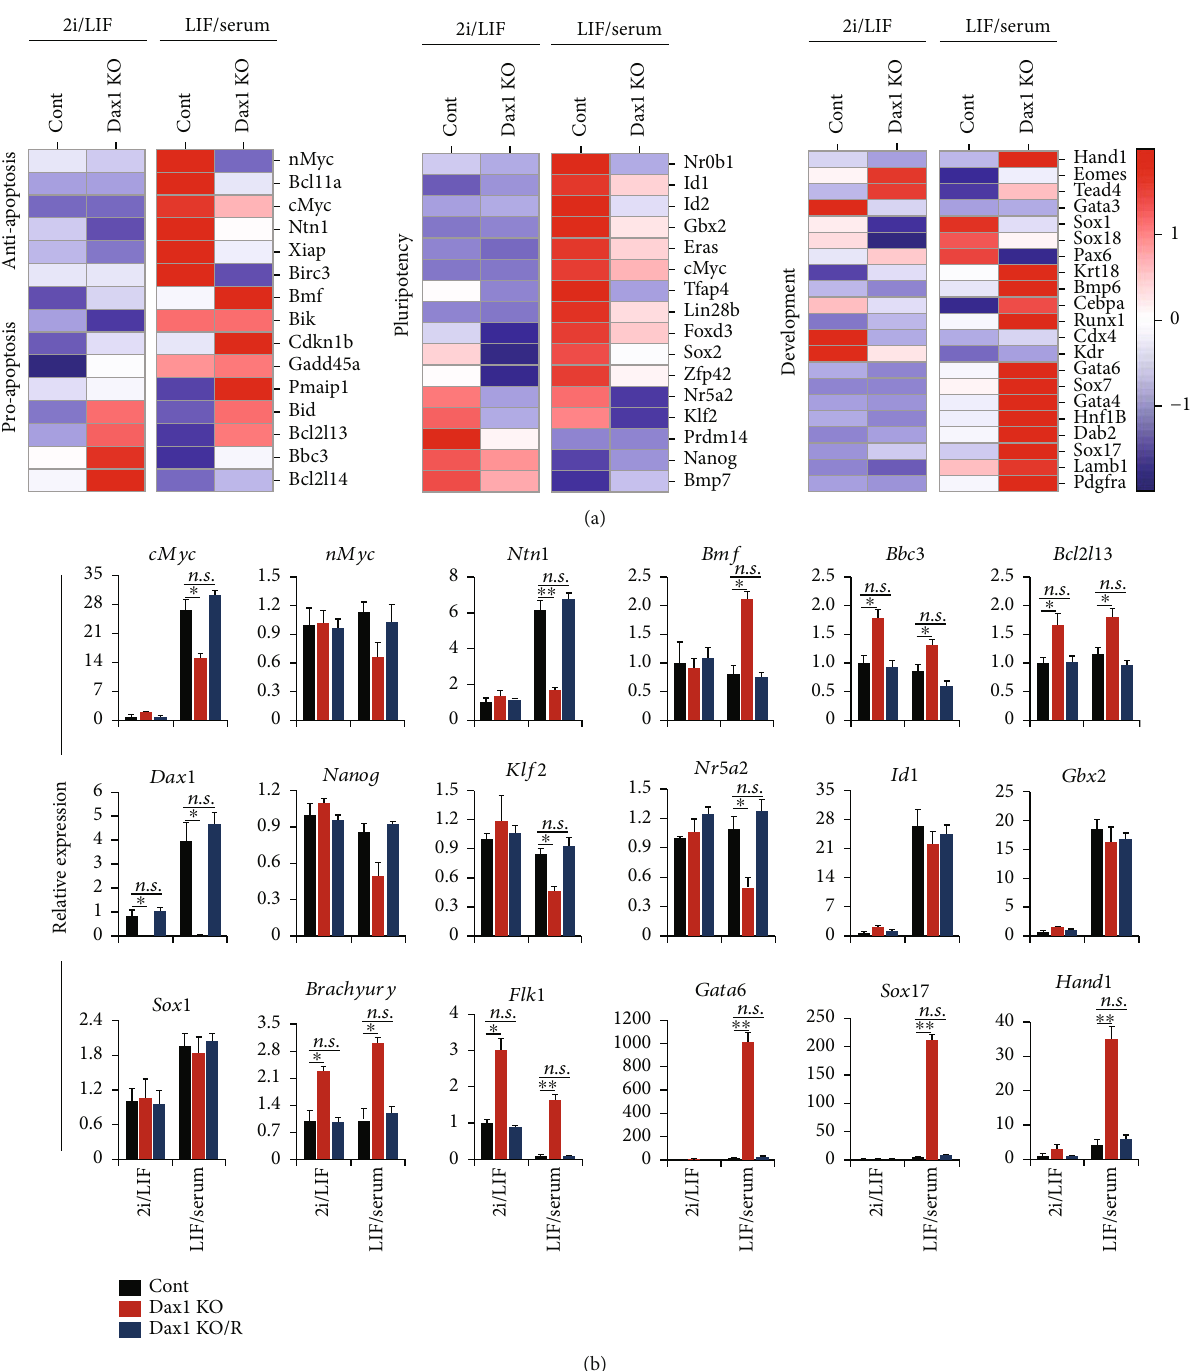
Figure 6: Expression of self-renewal-related genes after Dax1KO in di ff erent pluripotency states. (a) Heatmap of the apoptosis-related genes, pluripotency-associated genes, and lineage commitment genes after Dax1KO in 2i/LIF and LIF/serum. (b) qRT-PCR analysis of the indicated genes. Data are normalized to Gapdh and shown relative to WT ESCs (set at 1.0). Data are represented as mean ± SD ; n = 3 . ∗ P ≤ 0 : 05 ; ∗∗ P ≤ 0 : 01 . All P values were calculated using Student ’ s t